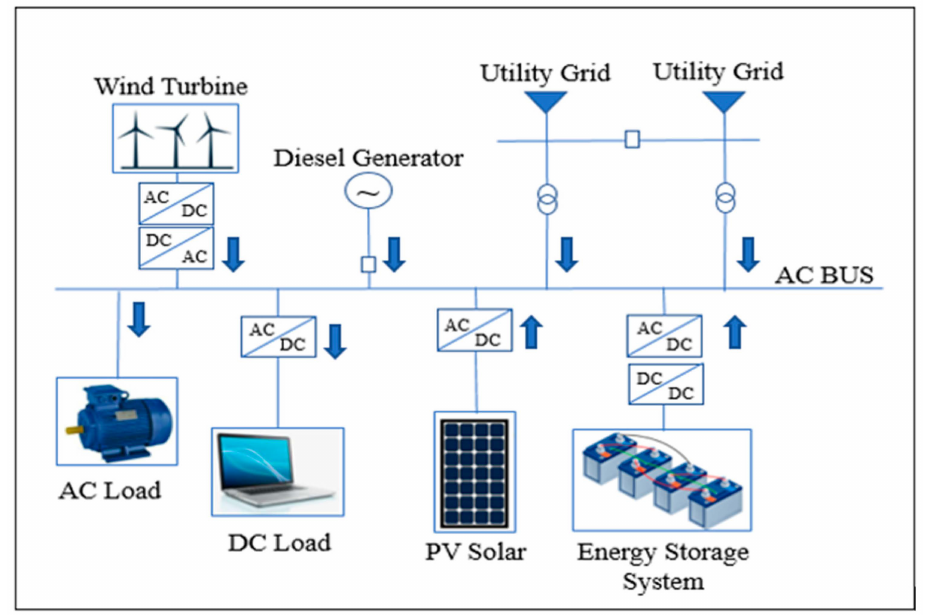
Figure 3. Alternative current (AC) MG architecture.